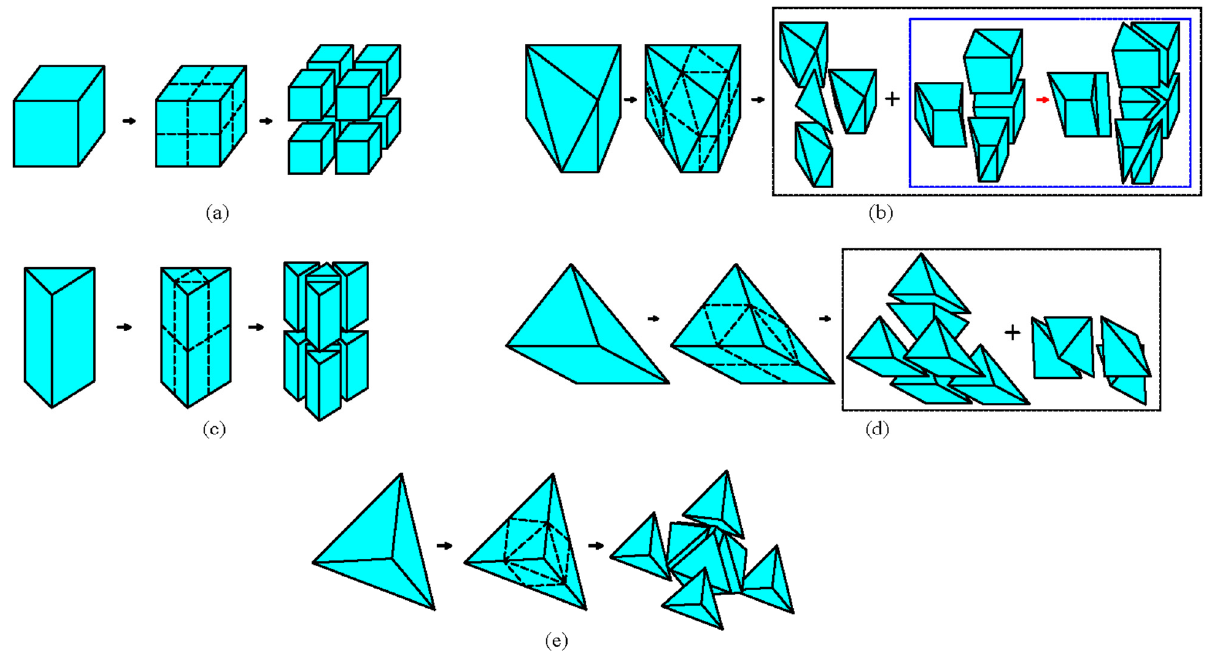
Figure 3. Element segmentation: ( a ) cube; ( b ) heptahedron; ( c ) triangular prism; ( d ) pyramid; ( e ) tetrahedron.